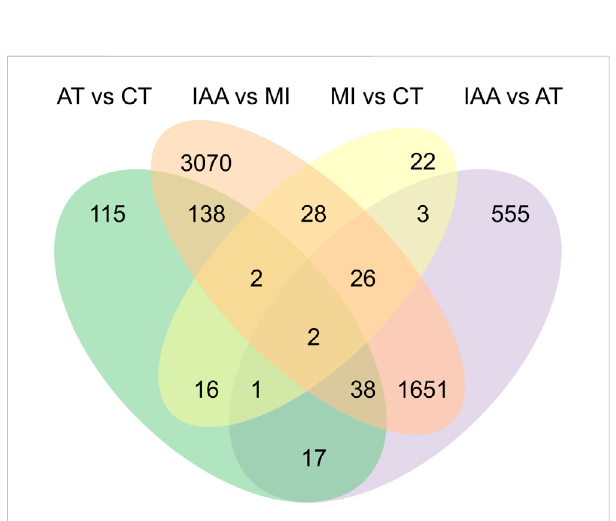
FIGURE 3 Venn diagram of DEGs among four pair-wise comparison groups.